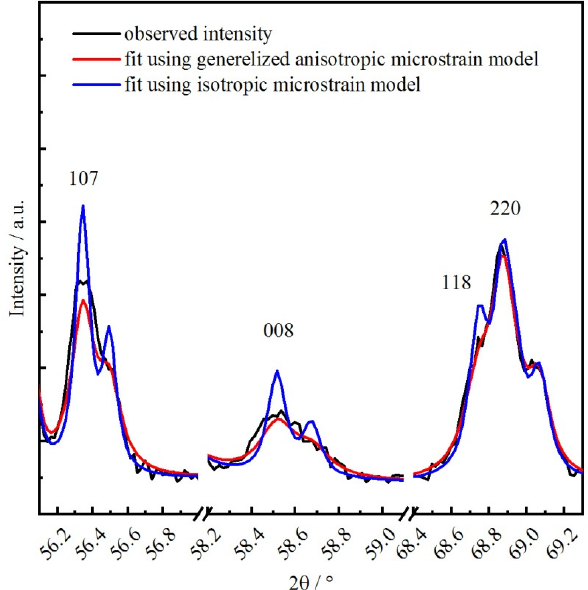
Figure 4. Comparison of the Rietveld fit for 107, 008 and 118 reflections between the isotropic and anisotropic microstrain models (implemented in GSAS-II software [43]) derived for LCNO_01_t. CuK α